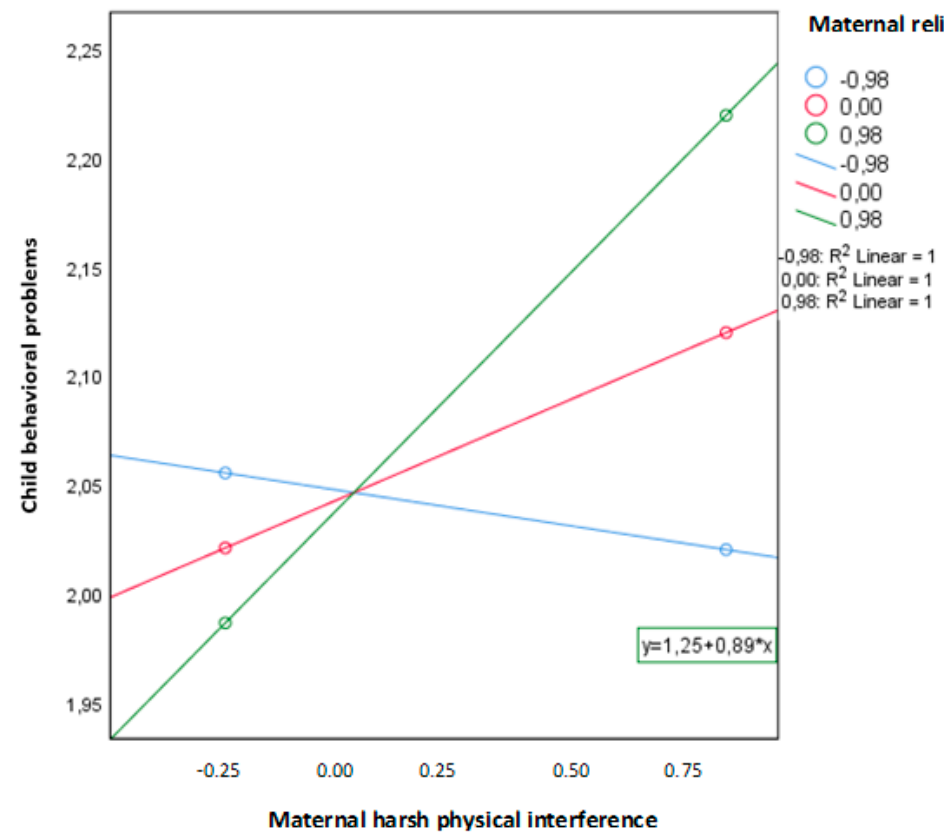
Figure 2. Moderating effect of maternal religiosity for the relation between maternal harsh physical parenting and child behavioral problems.